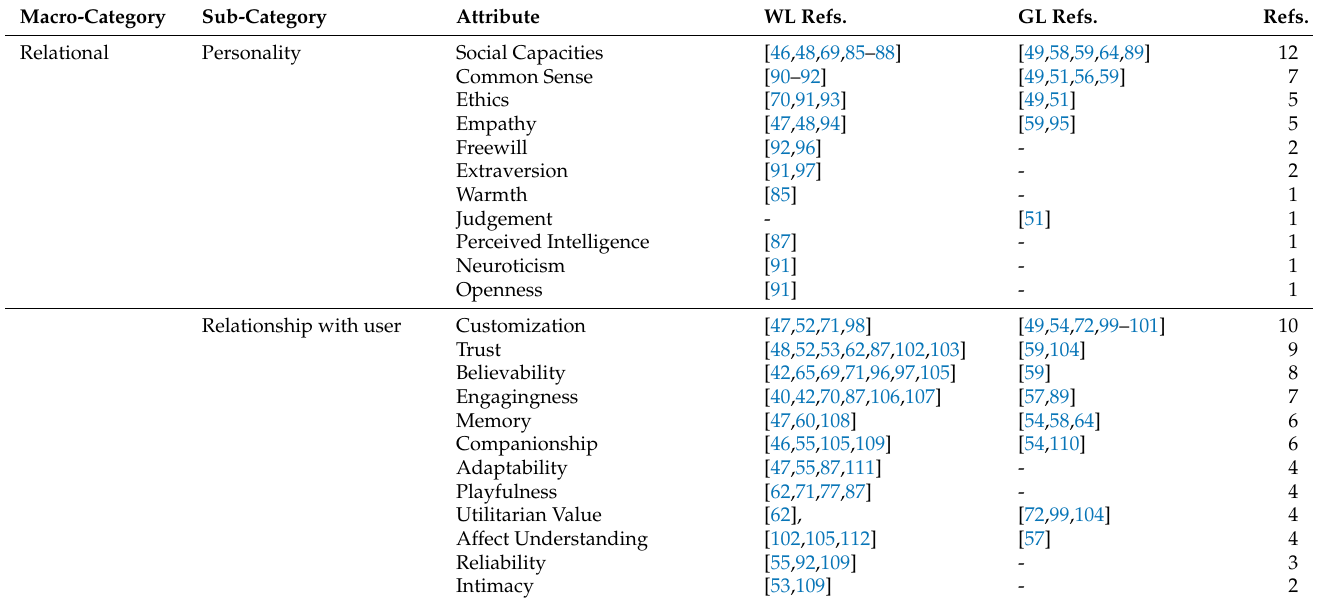
Table 5. Complete list of quality attributes in primary